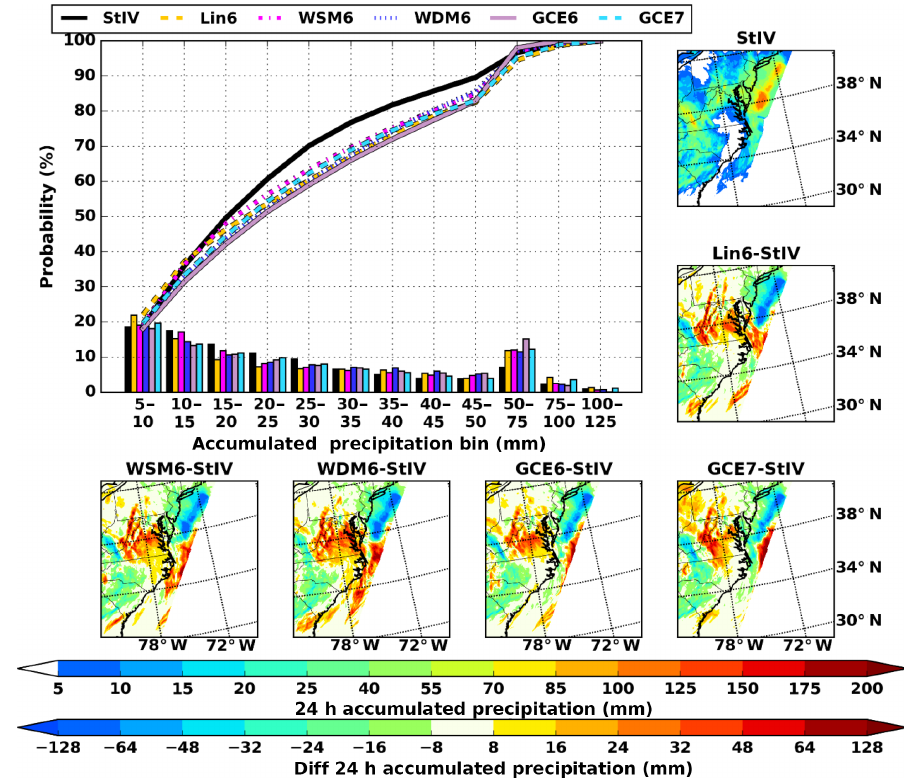
Figure 7. Case 7, 24h precipitation accumulation and their differences (mm, small panels) and corresponding probability density and cu- mulative distribution functions (big panel) of these same data derived from Stage IV and WRF model output. Accumulation period is from 18:00UTC, 12 March 2010–18:00UTC, 13 March 2010. Shown differences are model – Stage IV